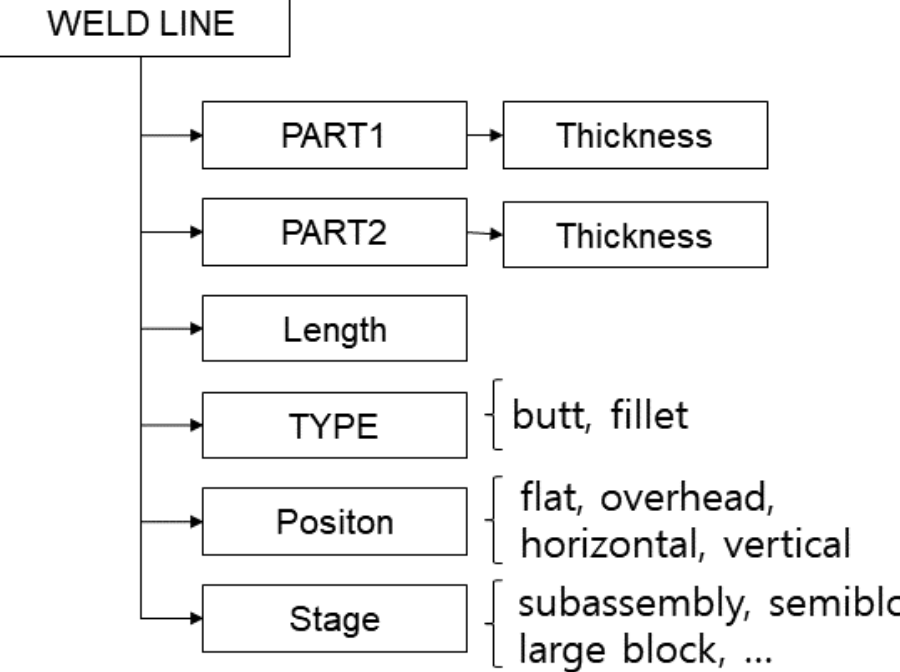
Figure 10. Data associated with weld